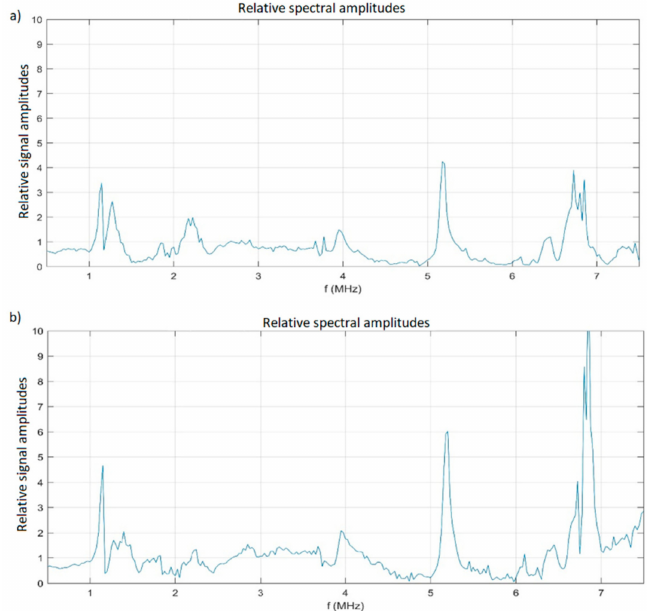
Figure 5. Spectral amplitudes of HApAg5 ( a ) and HApAg20 ( b ) relative to those of the reference liquid, for the first echo.